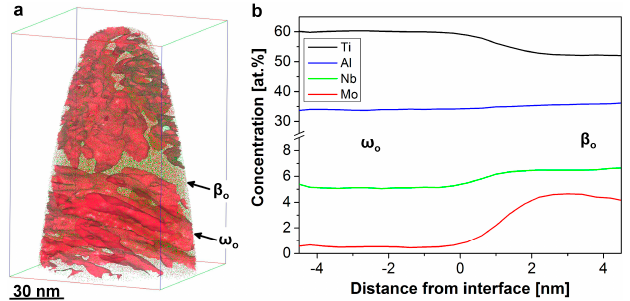
Figure 6. APT reconstruction containing β o and ω o phase and proximity histogram. ( a ) Only Nb (green) and Mo atoms (red) are indicated for clarity. Moreover, isoconcentration surfaces have been generated at 1.3 at% Mo. These interfaces clearly separate regions of β o and ω o phase. ω o precipitates show parallel arrangements, which correspond to the predominating orientation relationship (OR) (see text); ( b ) Concentration profiles calculated as proximity histograms across the interfaces depicted in ( a ) are shown. The concentration of Al remains nearly unaltered, whereas Mo and Nb on the one hand and Ti on the other hand show an opposing partitioning behavior.